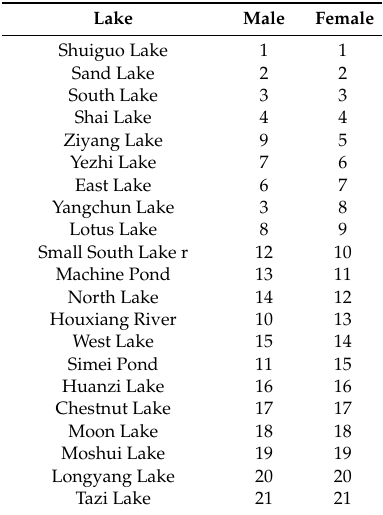
Figure 7. Ranking of the check-in point density of users of di ff erent genders: ( a ) Male; ( b ) female. Table 3. Lake density ranking by